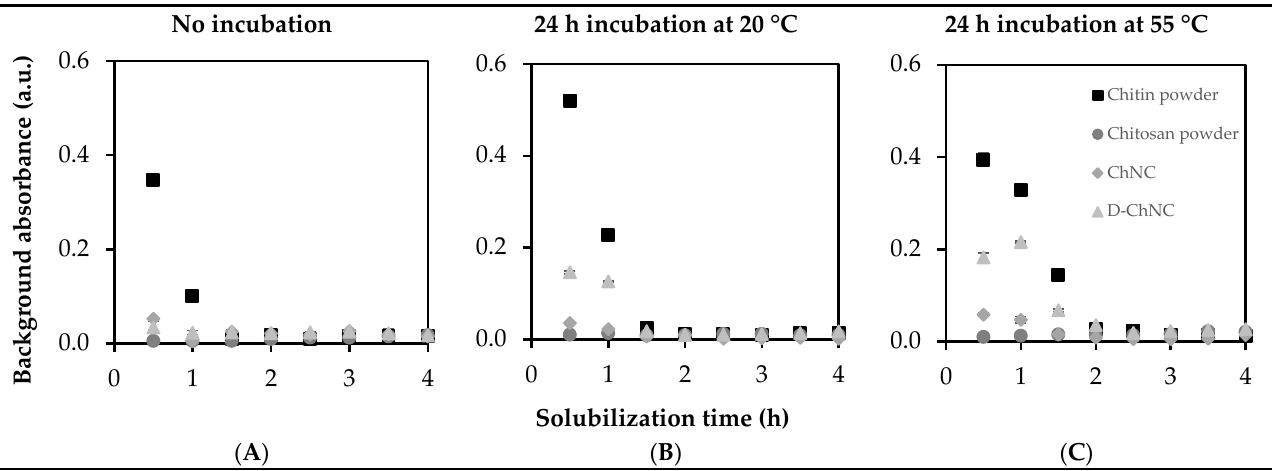
Figure 1. Background absorbance at λ = 310 nm for chitin and chitosan powder, chitin nanocrystals (ChNC), and deacetylated chitin nanocrystals (D-ChNC); measured ( A ) during solubilization (no incubation), ( B ) after 24 h incubation at 20 °C; and ( C ) after 24 h incubation at 55 °C. (UV-vis spectra of samples can be found in Appendix Figures A6 – A8).